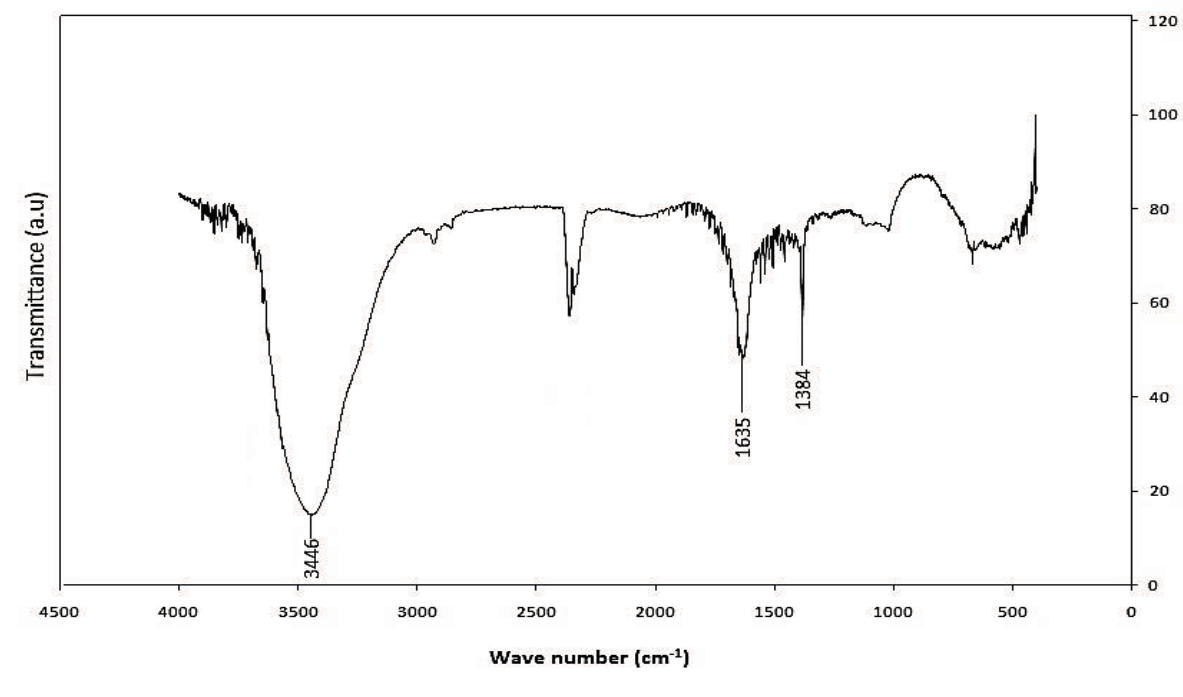
Figure 9. FTIR spectrum of